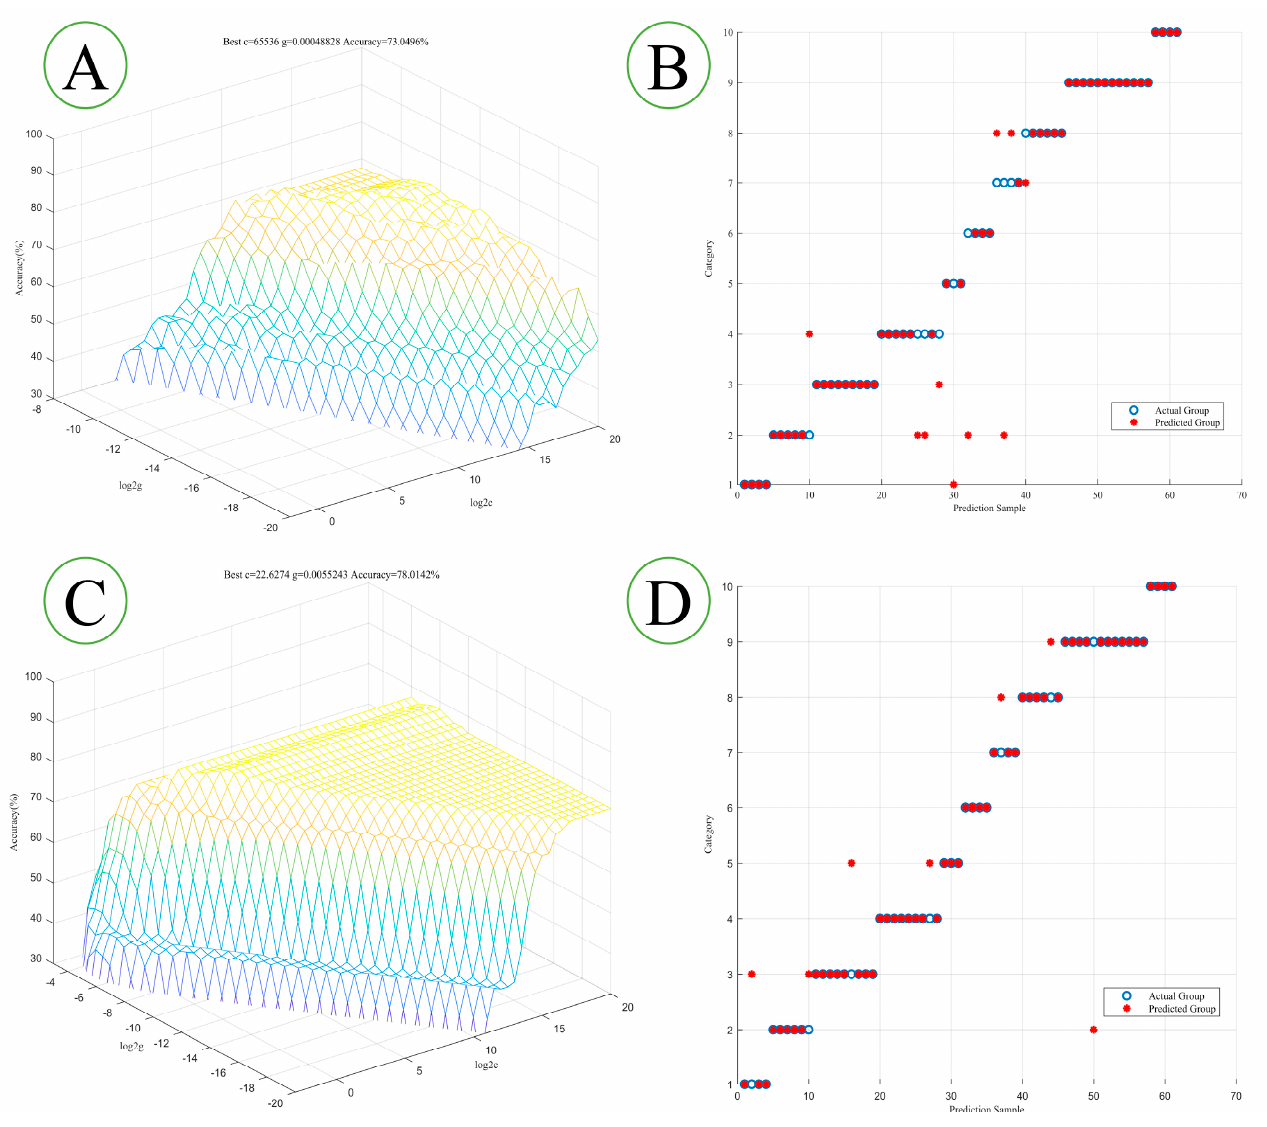
Figure 6. The optimal separation hyperplane of the SVM model based on VIP, and the classification